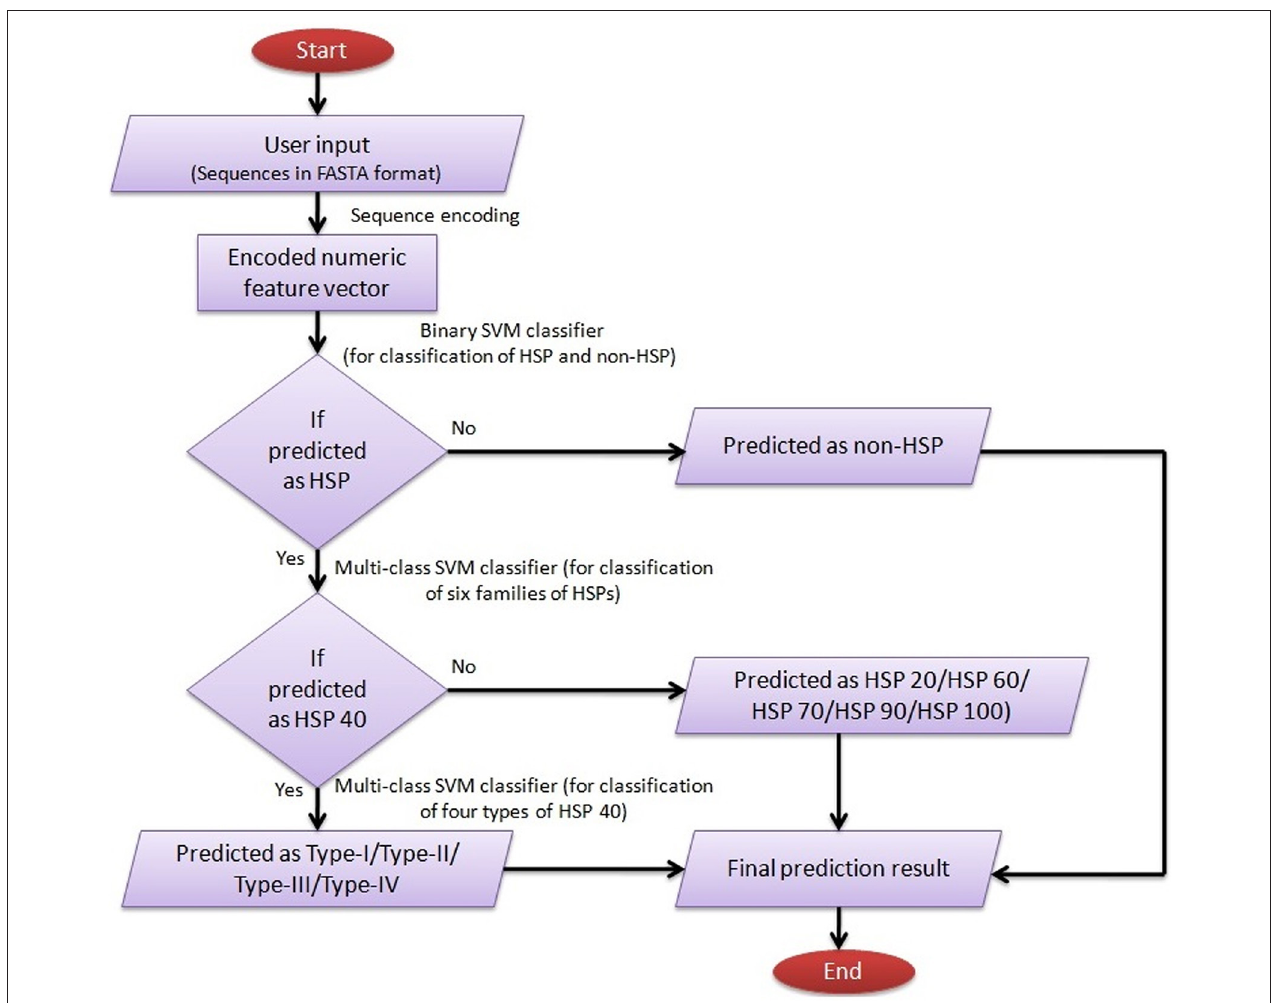
FIGURE 6 | Flow diagram showing the step-wise working procedure of the developed prediction server